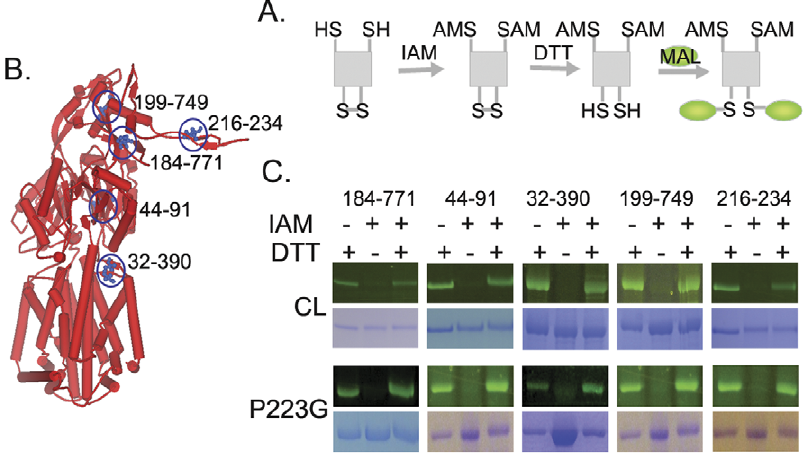
Figure 6. Disulfide trapping analysis of AcrB tertiary structure. A. Schematic illustration of the blocking-reducing-labeling procedure. B. The locations of reporter Cys pairs in the structure of AcrB were highlighted using black circles and blue ball-and-stick models. Residue numbers of the Cys mutations were marked. C. AcrB tertiary structure as revealed by the disulfide trapping method. The extents of disulfide bond formation for each reporter Cys pair were very similar in AcrB P223G as compared to WT AcrB. Therefore, the overall conformation, or tertiary structure, of AcrB P223G was very similar to that of WT AcrB.